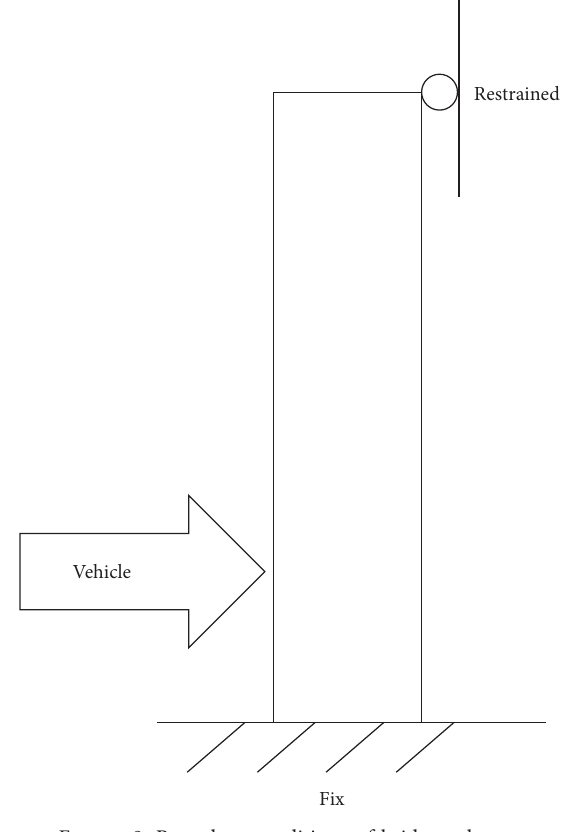
Figure 9: Boundary conditions of bridge column. Table 4: Column types based on slenderness